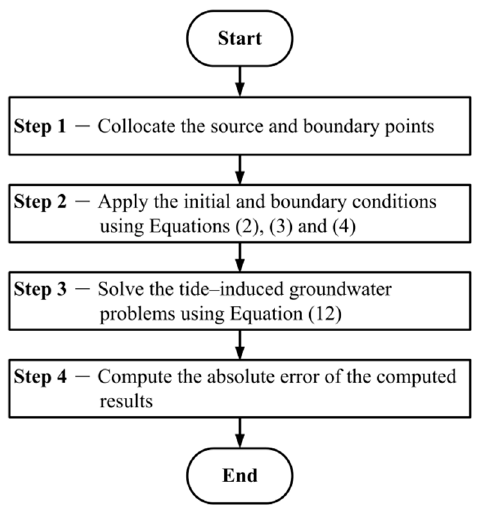
Figure 1. The schematic flowchart diagram of this study.